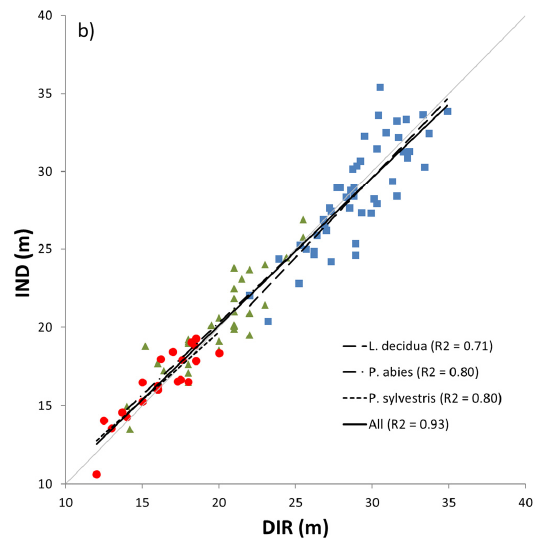
Figure 3. Regression analysis between ( a ) tree heights derived by airborne laser scanner data (ALS = ALS10) and tree heights derived from direct field ‐ based measurement (DIR); ( b ) tree heights derived from indirect field ‐ based measurement (IND) and DIR, considering the whole dataset (All) and the three species separately. Each dot corresponds to a single tree (blue square = Larix ; green triangle = Picea ; red circle = Pinus ).